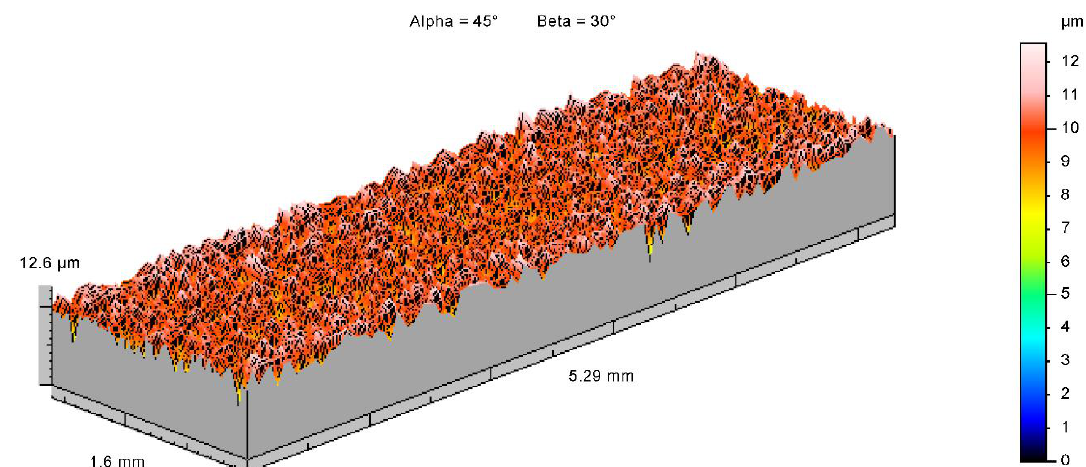
Figure 21. Stereometric surface image before machining.